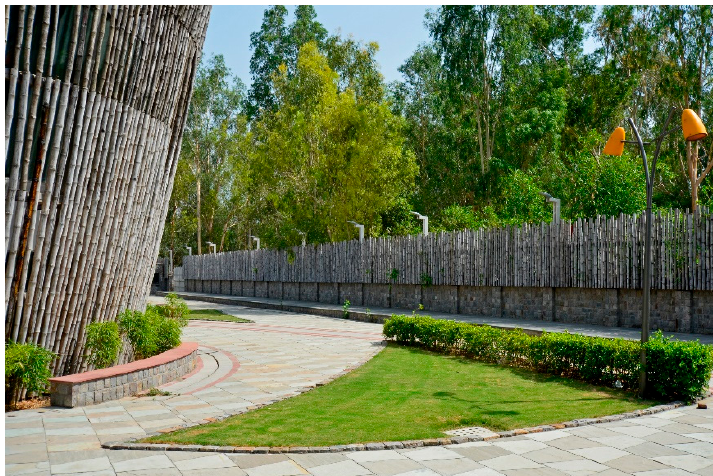
Figure 32. Tall bamboo-clad structures respond to the green belt surrounding the Dilli Haat site (Photo: Author).